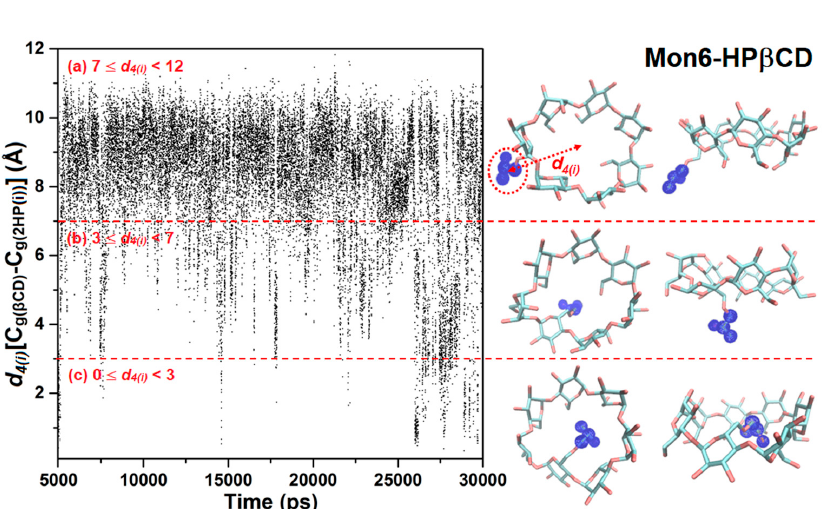
Figure 7. The distance of the centers of mass between the β CD ring and HP group, d 4(i) [C g( β CD) –C g(HP(i)) ] for Mon6-HP β CD at 300 K.